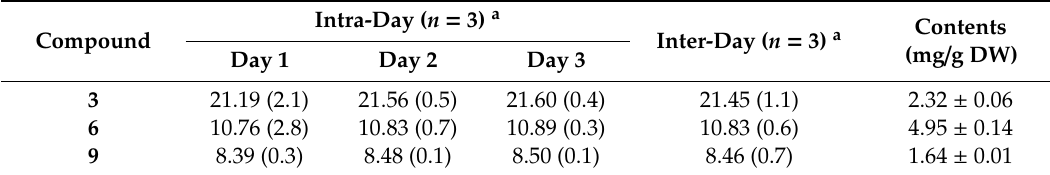
Table 4. Intra- and Inter-day precision of analysis and the contents of three major compounds in I. lactea var. chinensis